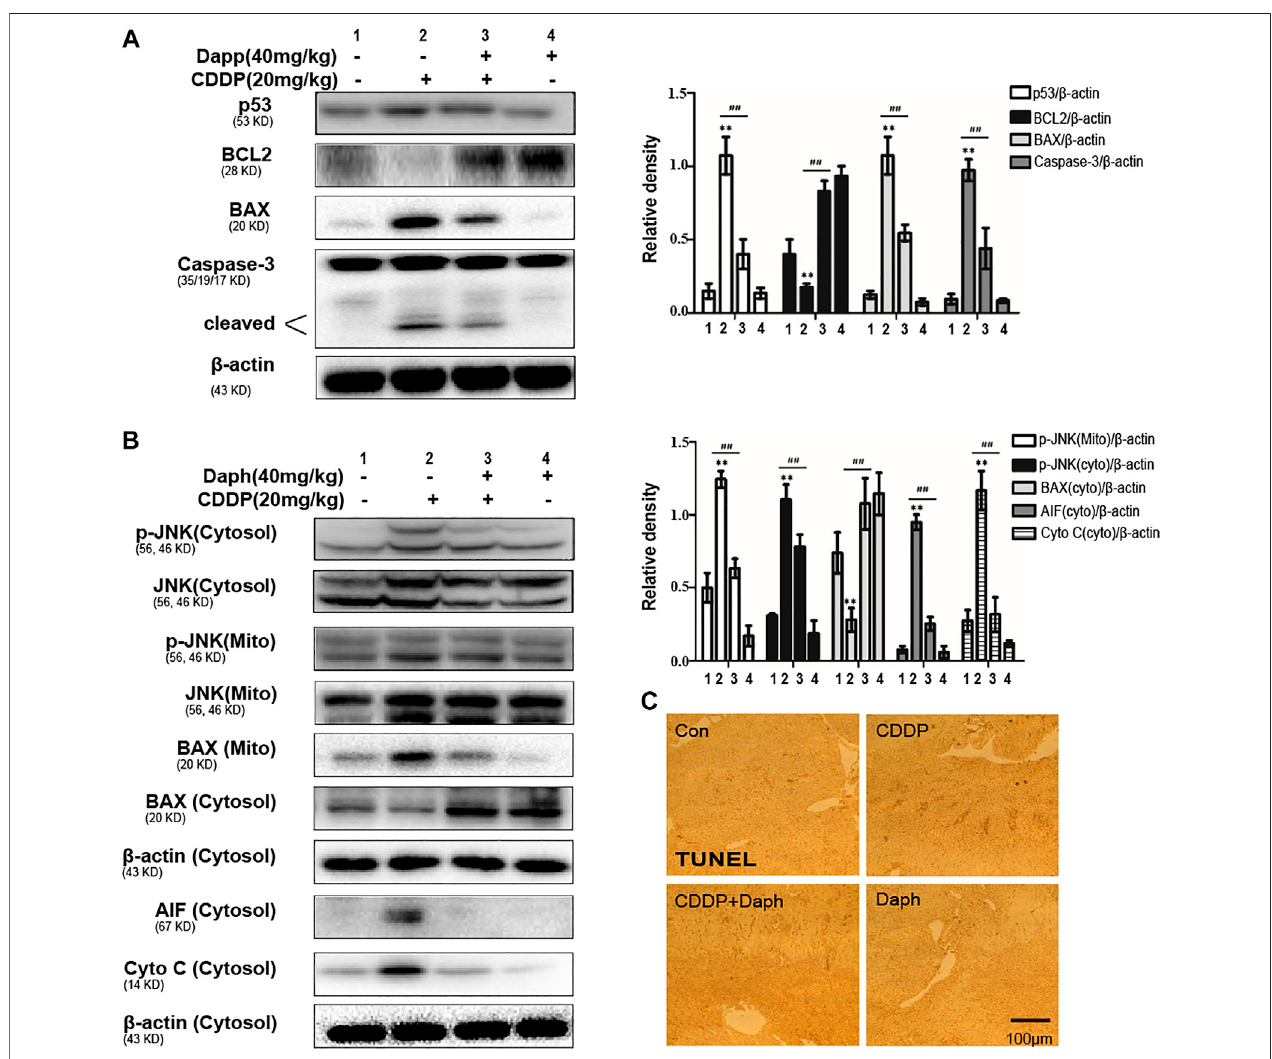
FIGURE 4 | Daph ameliorated apoptosis and mitochondrial dysfunction in CDDP-induced AKI in WT mice. (A) Effects of Daph on CDDP-induced p53, Bcl2, Bax and cleaved caspase-3 in the kidneys from WT mice. (B) Effects of Daph on CDDP-induced phosphorylated JNK, Bax, AIF and cytochrome c in mitochondrial and cytosolic. (C) Representative images of the TUNEL assay of kidney. * p < 0.05 and ** p < 0.01 vs. the control group; # p < 0.05 and ## p < 0.01 vs. the CDDP group.